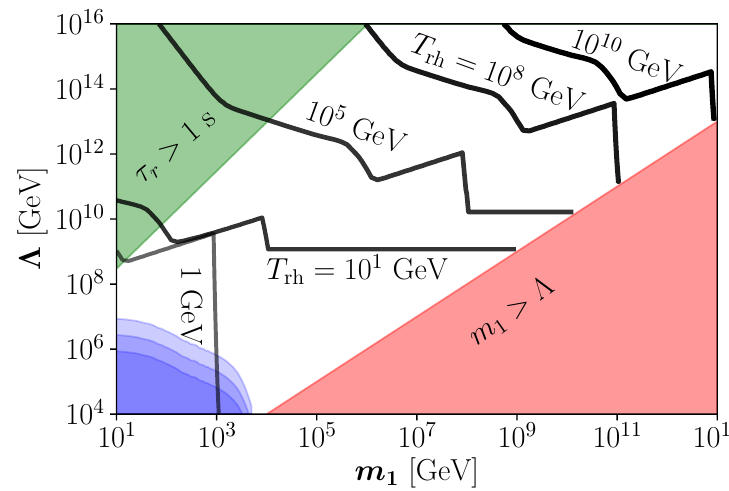
Figure 6 . Parameter space required to reproduce the observed DM abundance for m (cid:31) = 1 MeV and m r = m 1 = 10 3 , for several values of T rh . The blue areas are excluded by resonant searches at LHC and represent the current bound and our prospects for the LHC Run-3 and the High-Luminosity LHC in the (cid:13) (cid:13) channel [62, 63], see text. The green corner corresponds to radion lifetimes longer than 1 s. In the red area ( m 1 > (cid:3)) the EFT approach breaks